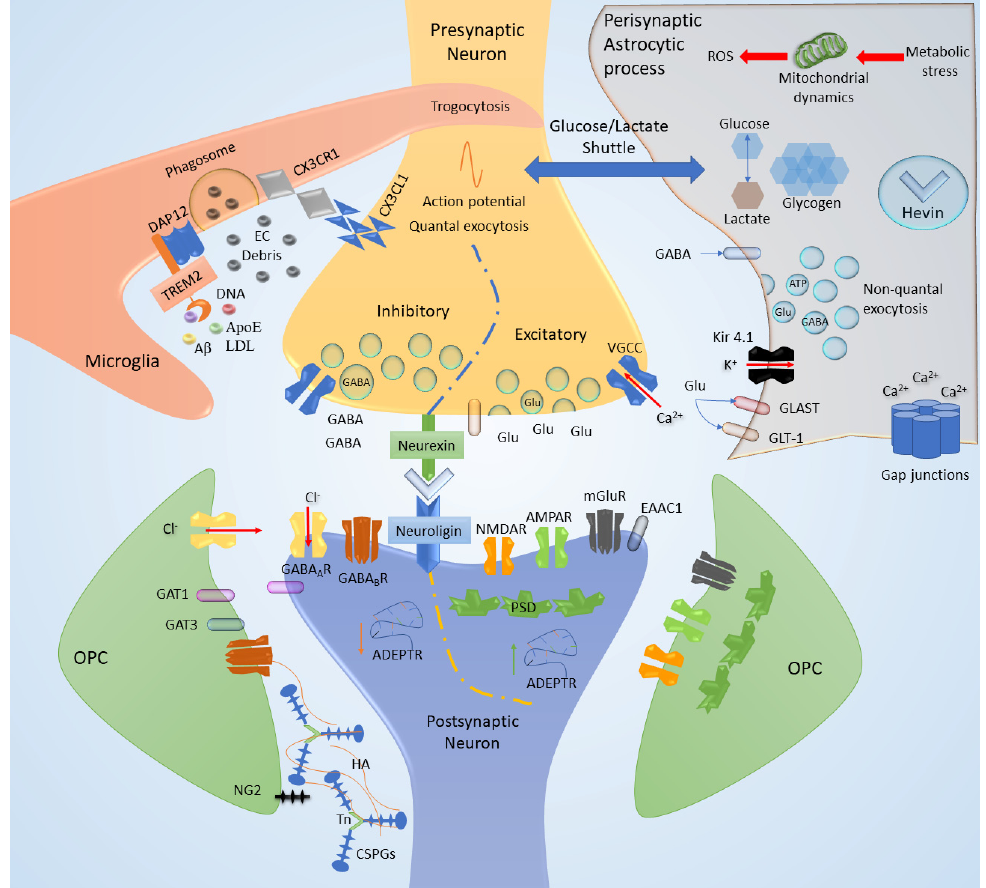
Figure 2. Synaptic cleft components. The schematic representation of a synapse with both excitatory and inhibitory assets emphasizes the contribution of cell adhesion between synaptic terminals (neurexin/neuroligin complex), the stabilization of astrocytic hevin, and the extracellular (EC) matrix proteins functional anchorage. The role of ionic fluxes and ionotropic/metabotropic receptors is peculiarly regulated considering each depicted element. These transmitters can be secreted through quantal vesicular exocytosis through neuronal activity and via non-quantal secretion considering the so-called “gliotransmission”. Moreover, astrocytes are responsible for metabolic coupling and major mitochondrial dynamics. The microglial scavenger and immunologic role through specific receptors (the sensome) is widely more complex than the showed exemplification. Here, we depicted the triggering receptor expressed on myeloid cells 2 (TREM-2) and the DNAX-activation protein of 12KDa (DAP12), which can interact with proteins, lipoproteins and DNA. The fractalkine receptor/ligand (CX3CR1/CX3CL1) aids the association between the neuron and microglia at the synaptic level, where the partial engulfment of spines or axons is called trogocytosis. Eventually, the synaptic scaffolds both, considering excitatory postsynaptic densities (PSD) or inhibitory arrangement of the cytoskeleton, can be regulated by non-protein elements, such as the activity-dependent transported long non-coding RNA (ADEPTR). GAT, GABA transporter; mGluR, metabotropic glutamate receptor; Kir, inward rectifying potassium channels; NG2, neural/glial antigen 2; EAAC1, excitatory amino acid carrier 1; GLAST, glutamate/aspartate transporter; GLT-1, glutamate transporter 1; HA, hyaluronic acid; Tn, tenascin; CSPG, chondroitin sulfate proteoglycan; AMPAR, AMPA receptor; NMDAR, NMDA receptor; VGCC, voltage-gated calcium channels.